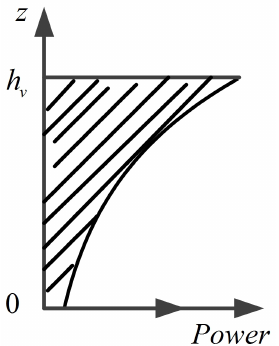
Figure 1. The profile of Random Volume over Ground